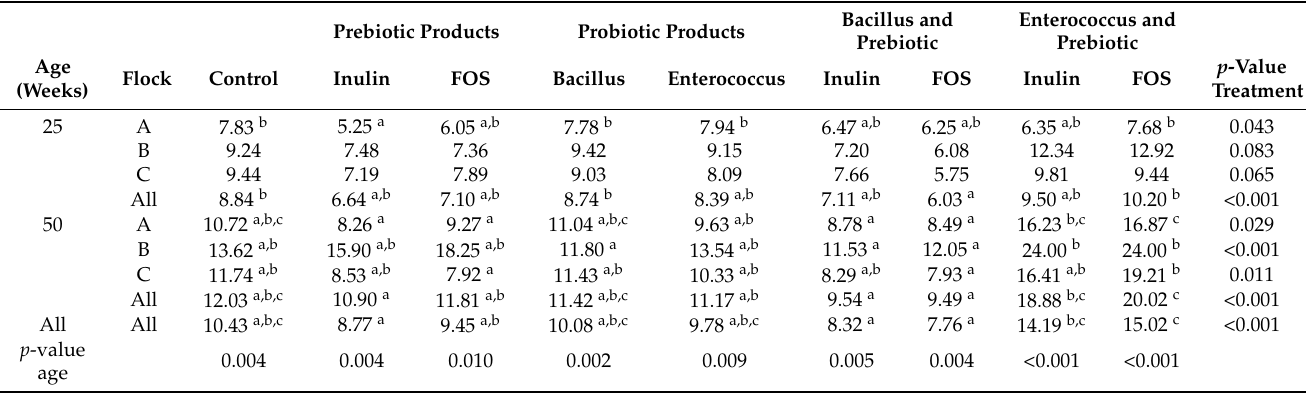
Table 3. Impact of pre- and probiotic products on the lag time of a pathogenic Salmonella Enteritidis strain after incubation in caecal slurries